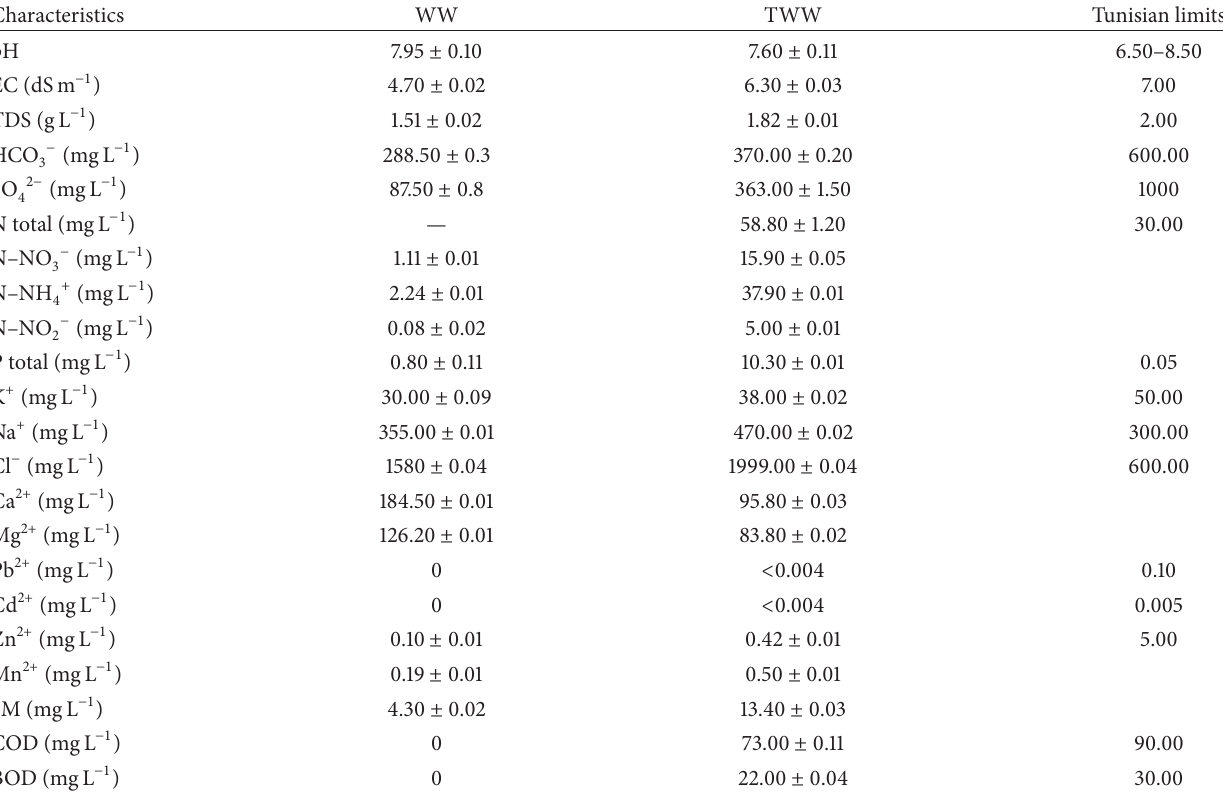
Table 1: Chemical properties of the well water (WW) and treated wastewater (TWW) used for irrigation in the experimental olive orchard.